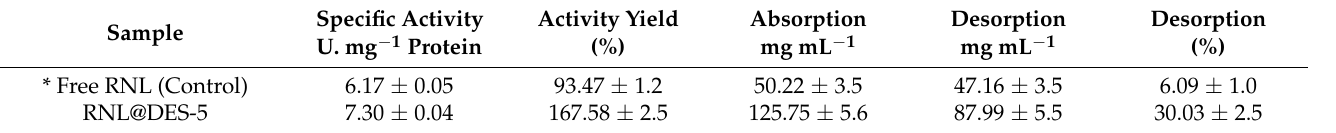
* RNL = Rhizopus niveus lipase. RNL@DES-5 = RNL in menthol:decanoic acid (1:1), Conditions: concentration of lipase: 1 mg mL − 1 , 300 rpm, 2 h, pH 7.0, and 40 ◦